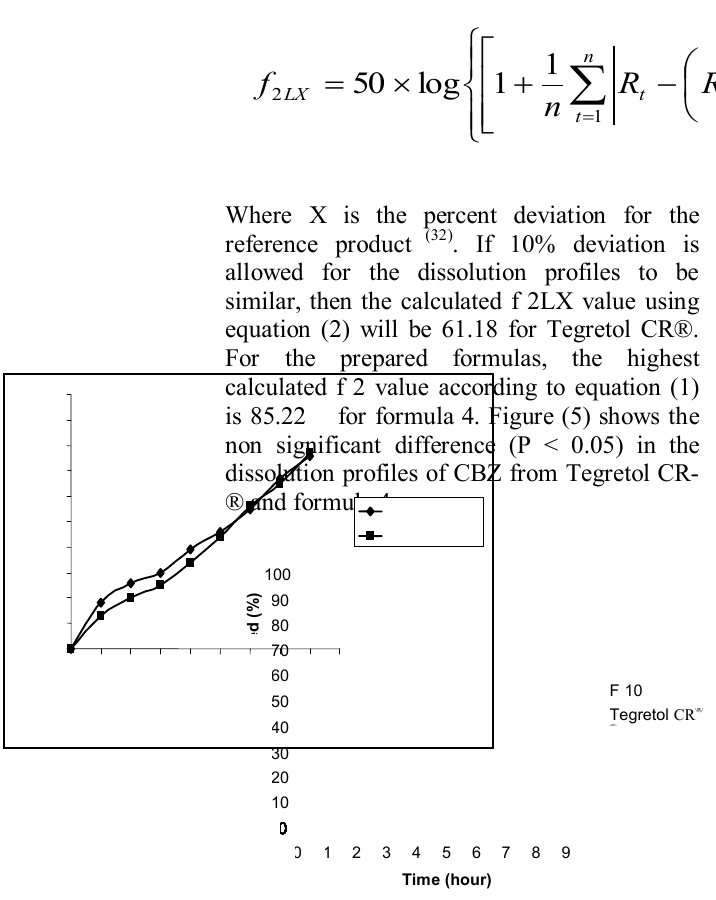
Figure 5: The release of CBZ from formula 10 compared to Tegretol CR ® in